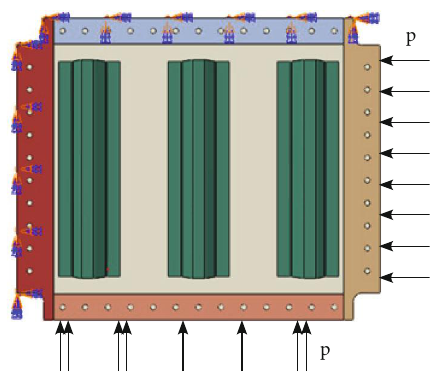
Figure 7: Pressure on the edge